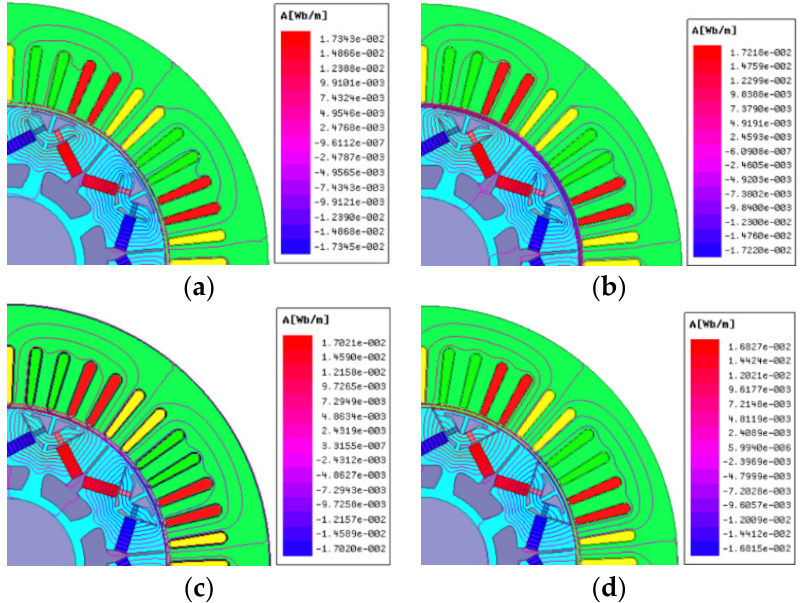
Figure 11. Distribution of magnetic lines with different lengths of magnetic barriers under the no load operation. ( a ) a = 5, ( b ) a = 7, ( c ) a = 10, ( d ) a = 13.